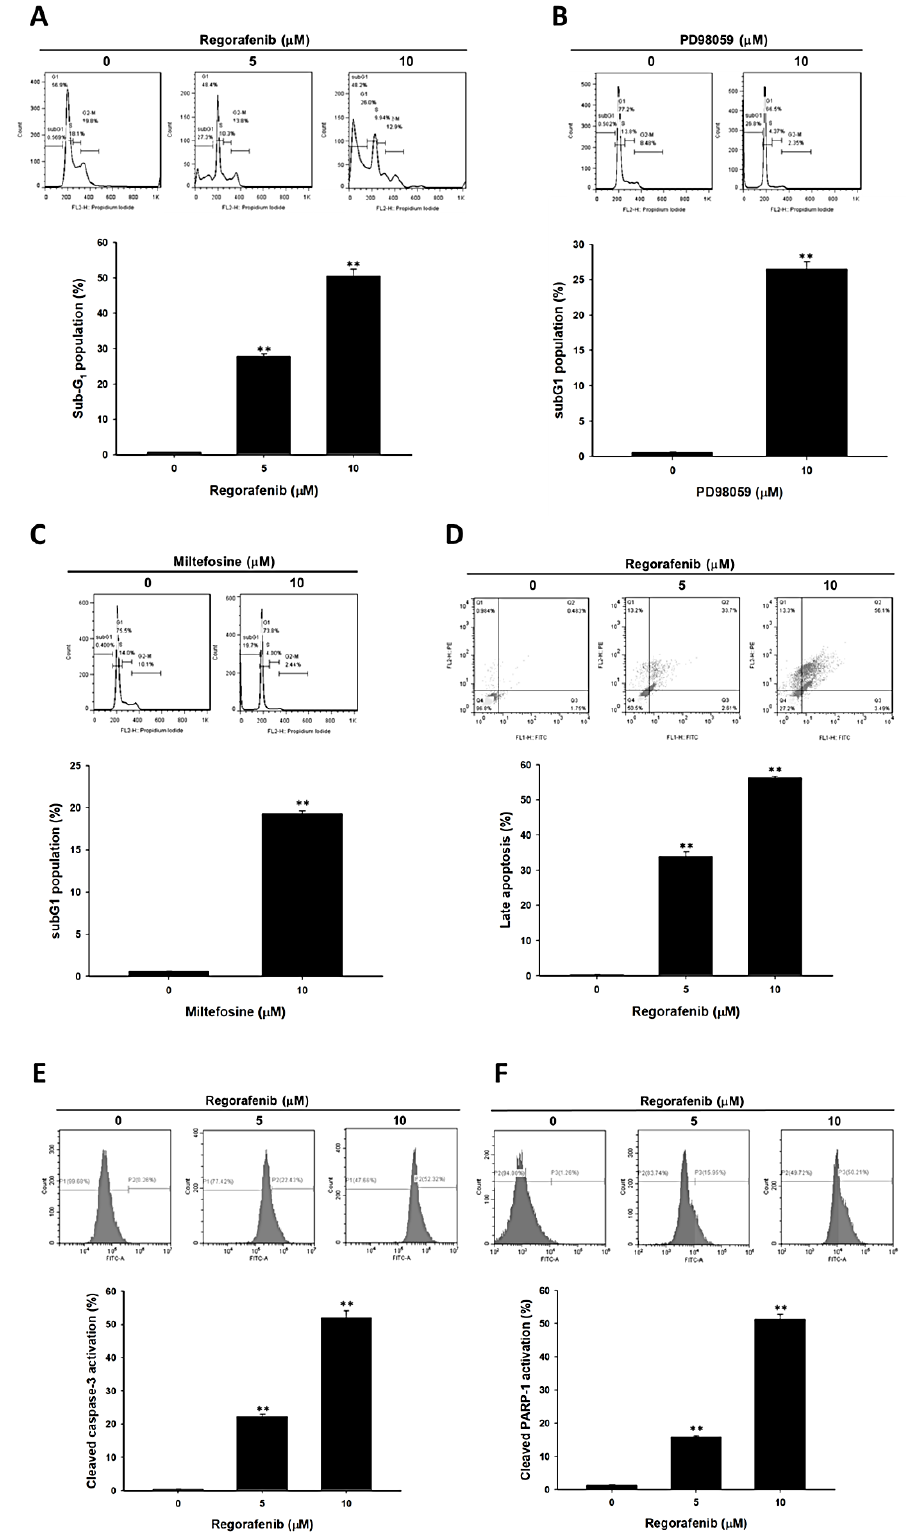
Figure 2. Apoptosis and DNA damage effect were increased by regorafenib. U-2 OS cells was treated with 0, 5, 10 µM of regorafenib, 10 µM of PD98059 or 10 µM of miltefosine for 48 h, respectively. The apoptosis effect was executed by flow cytometry. Cells were respectively stained with ( A – C ) PI for cell cycle; ( D ) annexin-V and PI for late apoptosis; ( E ) caspase-3 for apoptosis and; ( F ) cleaved PARP-1 for DNA damage. ** p < 0.01 vs. 0 µM of regorafenib.